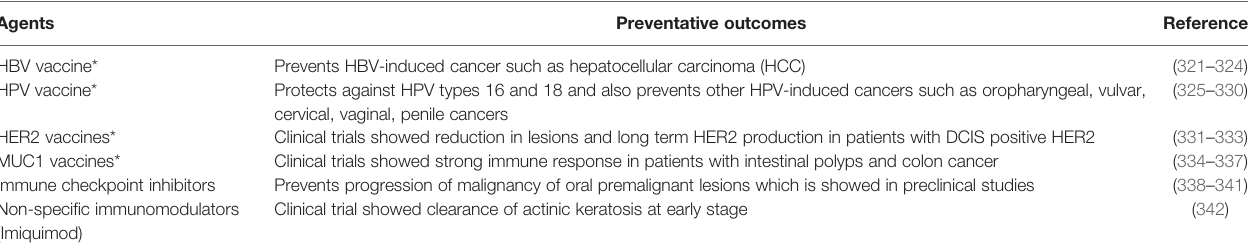
TABLE 3 | Major immunopreventive